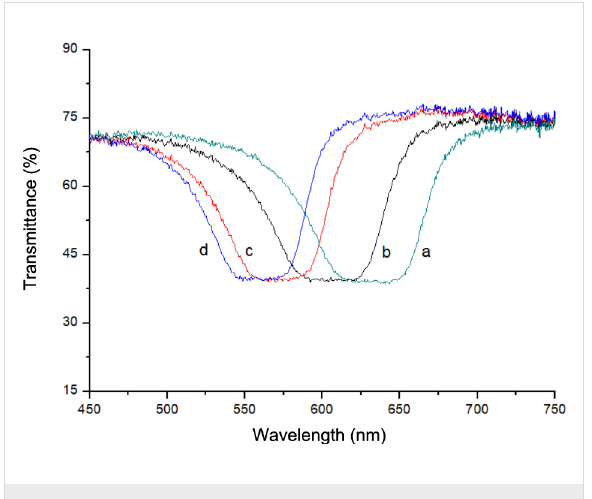
Figure 1: Spectral shift of the PBG as a function of the temperature: a) 12 °C (cyan line), b) 17 °C (black line), c) 22 °C (red line) and d) 25 °C (blue